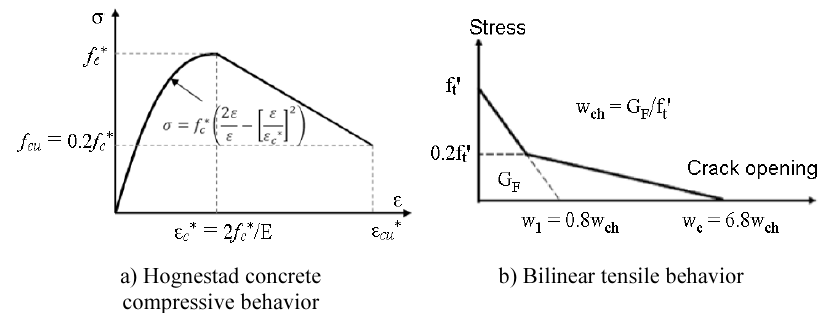
Fig. 2. Stress-strain behavior of concrete under uniaxial compression and tension